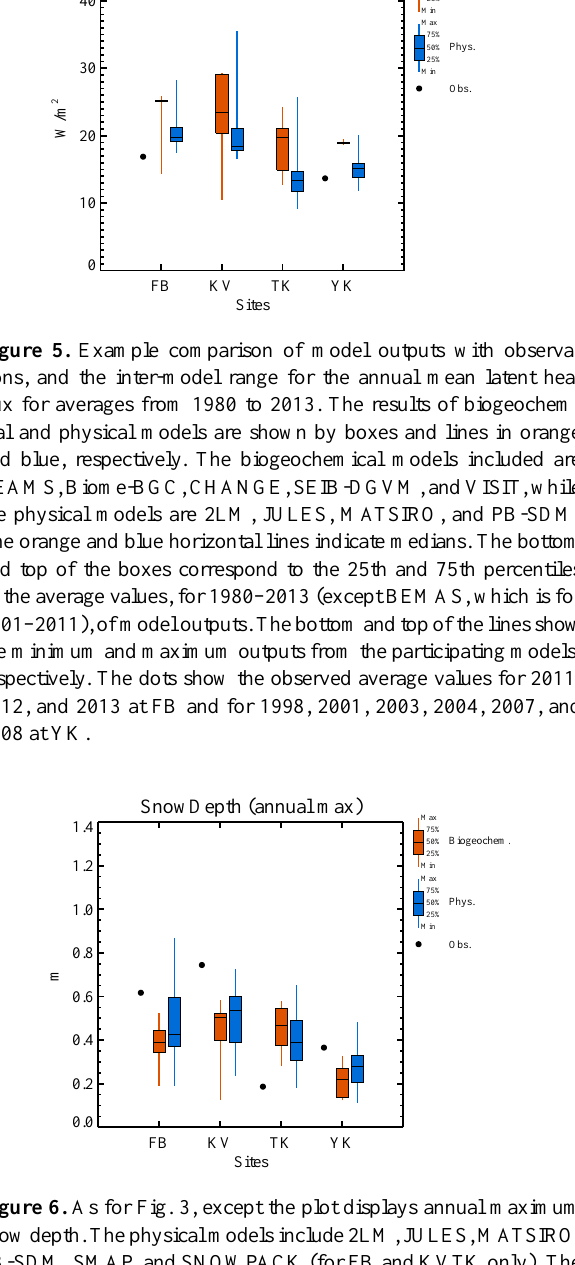
forest (two evergreen conifer: FB and KV; one deciduous conifer: YK) and the remaining site is tundra (TK). Three sites (FB, TK, and YK) are in the permafrost region, while